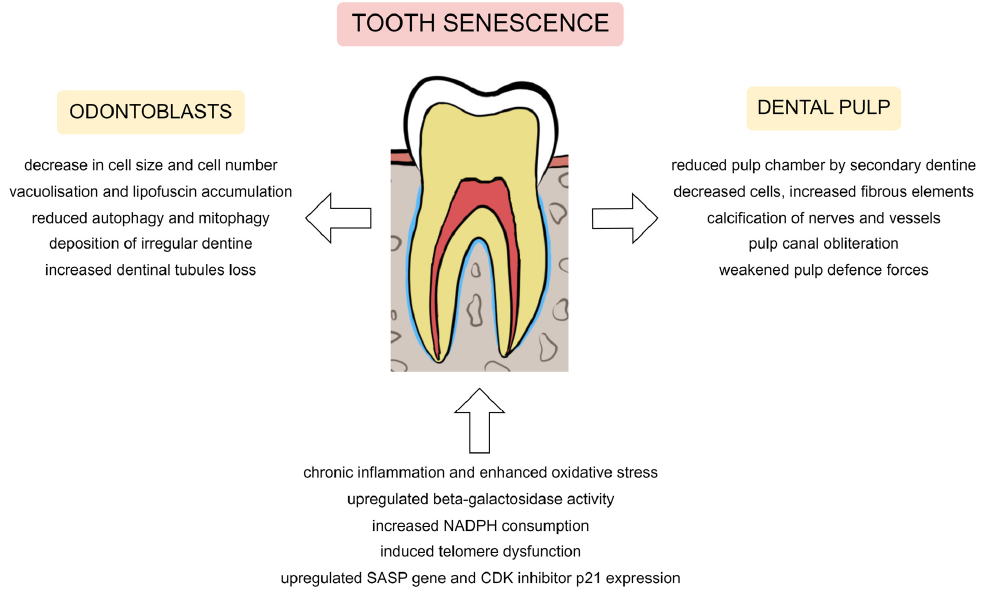
Figure 2. The endodontium senescence manifestations with metabolic and signalling mechanisms. Legend: NADPH, nicotinamide adenine dinucleotide phosphate; SASP, senescence-associated secretory phenotype; CDK, cyclin-dependent kinase.